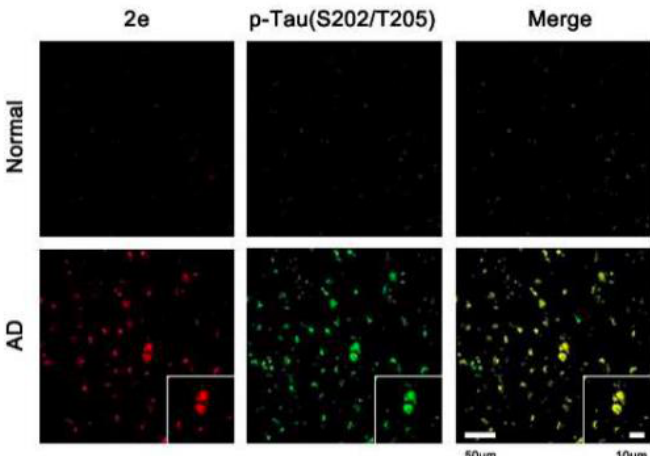
Figure 9. Confocal fluorescence images of healthy controls and AD brain sections after treatment with 6–((1E,3E)–4–(4–[dimethylamino]phenyl)-buta–1,3–dien–1–yl)–2,2–difluoro–4–319 isobutyl–2H– 1,3,2–dioxaborinin–1–ium–2–uide to detect tau filaments (first column) [103]. The second column demonstrates staining with a p –tau antibody (Ser202/Thr205). The third column shows the superimposed images demonstrating the accuracy of t-protein detection using the difluoroboron β– diketonate probe. Images are reprinted with permission of the publisher [103].